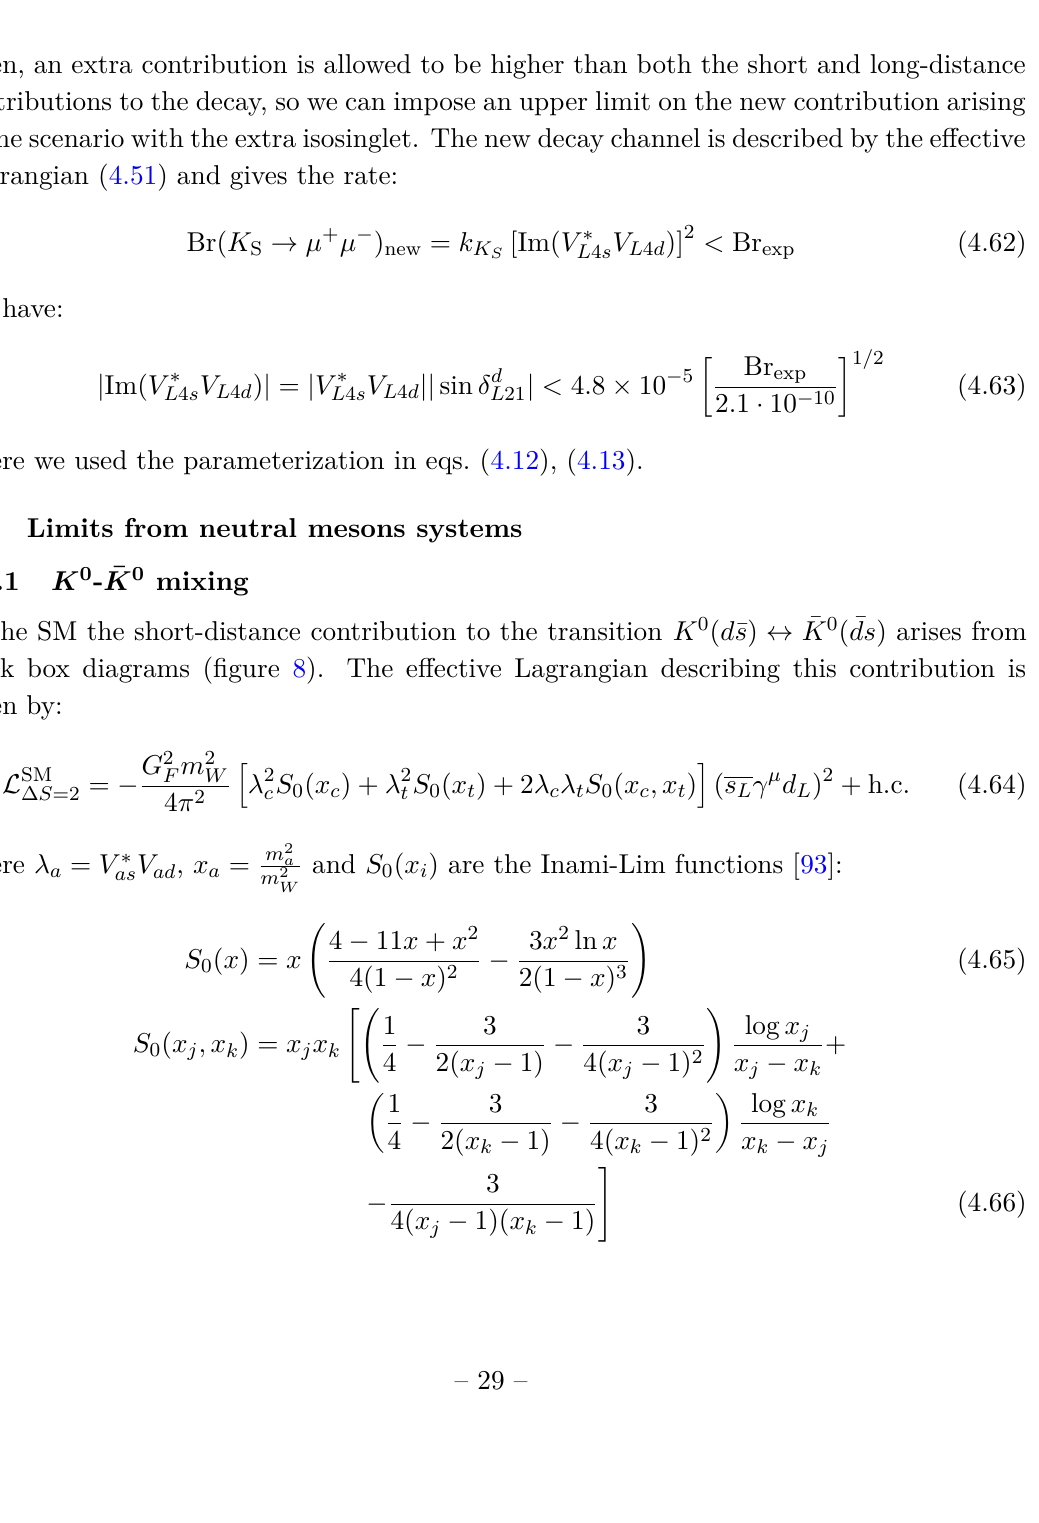
Figure 8 . Box diagram for the transition K 0 → ¯ K 0 in the SM, q α , q β = u, c, t